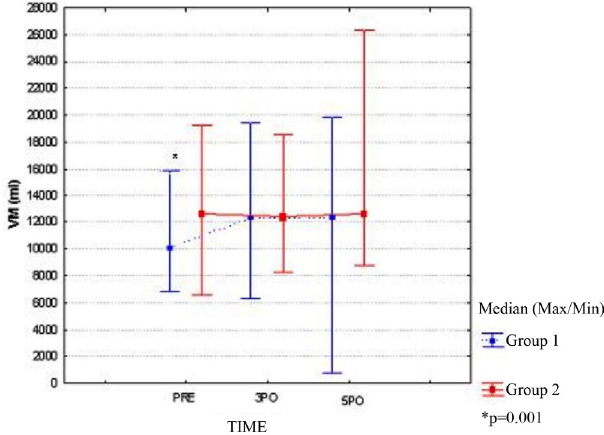
Fig. 5 - Median tidal volume variable at different times for the group treated with preoperative physiotherapy and without physical therapy preoperatively. Friedman test for comparison of moments in each group and Mann Whitney test to compare the groups at each time, *P<0.05.